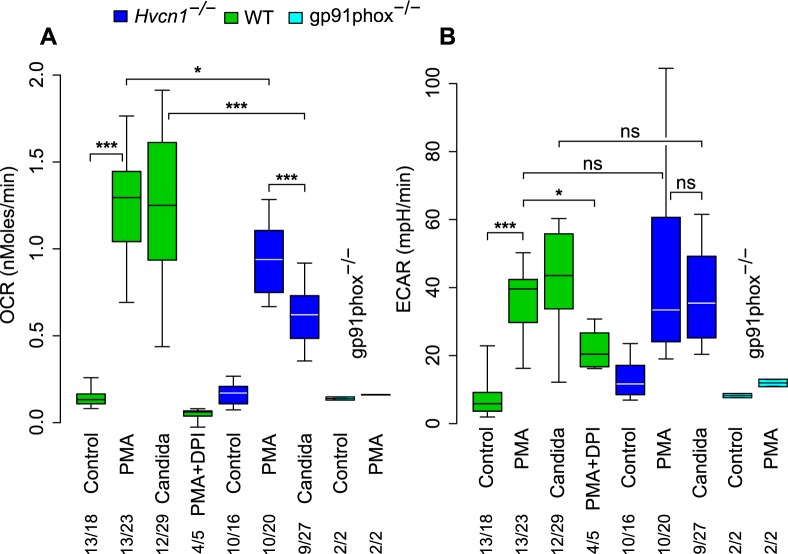
Oxygen consumption and extracellular acidification rate by neutrophils.(A) Oxygen consumption rate (OCR) and (B) extracellular acidification rate (ECAR) by neutrophils from WT, Hvcn1
-/- and gp91phox-/- mice in response to stimulation with PMA (with and without DPI) or opsonised Candida. The numbers of independent experiments is shown over the total number of measurements. Statistical significance: *** p<0.001, ** p<0.01 and * p<0.05. Differences between PMA stimulated WT and gp91phox-/- were p<0.001 in (A) and p<0.05 in (B). There were no significant differences in (B) between PMA and Candida or between WT and Hvcn1
-/- cells. Median, quartiles and 95% centiles are shown.